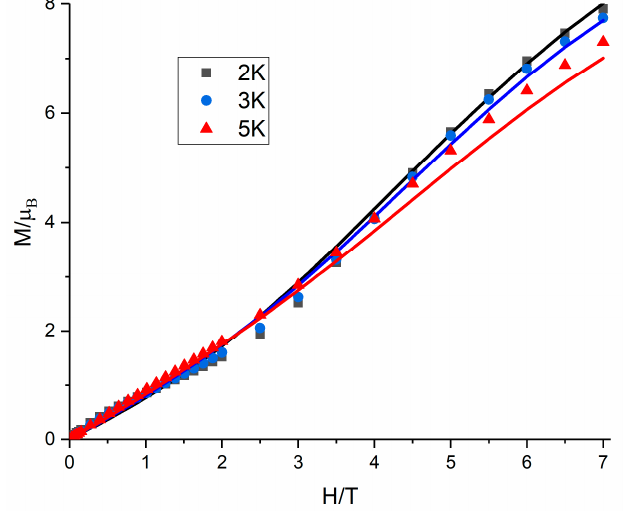
Figure 6. Plot of M vs. H for Na-1 at 2, 3 and 5 K. Solid lines for fitting.